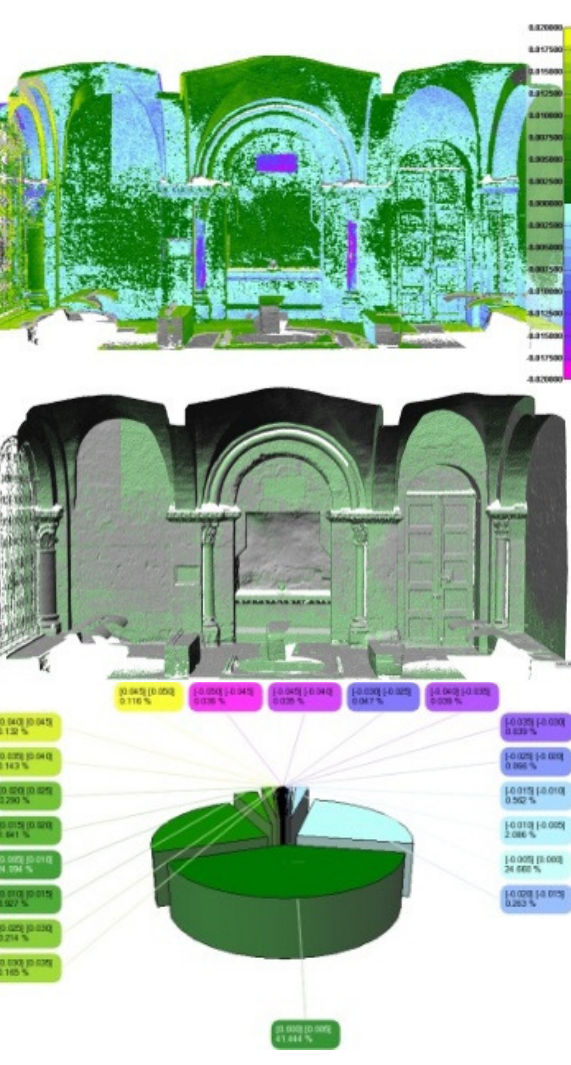
Figure 7. Error-map color mode, per scanner color mode and pie-type error distribution chart for subproject